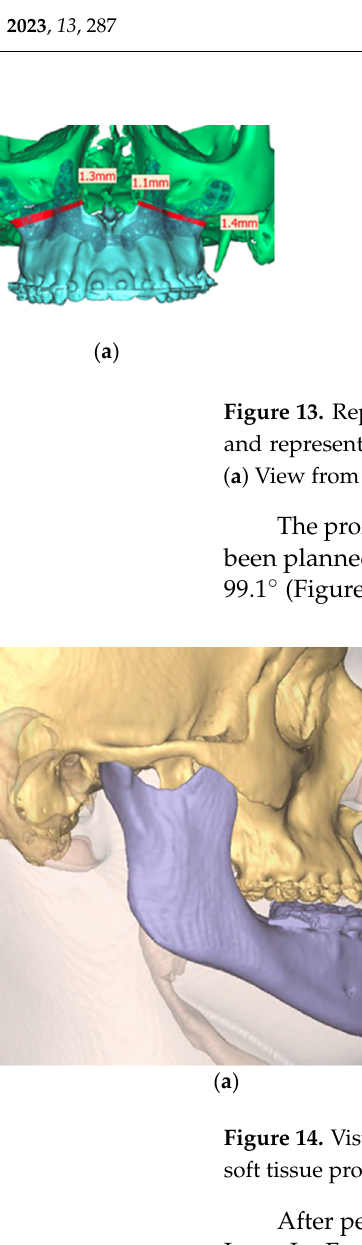
10 of 14 Figure 12. Overlay of the planned maxillary and mandibular position (green) with the postoperative position (orange). ( a ) View from the right ( b ). View from the left ( c ). View of the maxilla ( d ). View from palatal to the maxilla. In order to compare the differences in precision and accuracy maxillary positioning with the initial planning, we defined five landmarks that could not show variability. These included the tips of the mesio-buccal cuspids of the first molars, tips of the upper canines, and the incisor point. In addition, the analysis was performed using cephalometric refer- ence points: anterior nasal spine, the most anterior point of the tip of the anterior nasal spine in the midsagittal plane and posterior nasal spine. For each of the five landmarks indicated on the planned maxilla object, a correspond- ing landmark in the preoperative position was generated. The planned position of each landmark on the maxilla was compared to the preoperative position of each correspond- ing landmark in the X/Y/Z-directions. The preoperative maxilla with linked landmarks was then aligned to the postoperative maxilla using the alignment tool. Once aligned, the software measured the difference and movements in X, Y, and Z axis for each of the five points (Table 1). Table 1. Differences and movements in X, Y and Z axis post-operative (POP) of the maxilla com- pared to the pre-operative planning (PP) in mm . PP in mm Left/ Right PP in mm Anterior/ Posterior PP in mm Up/ Down PoP in mm